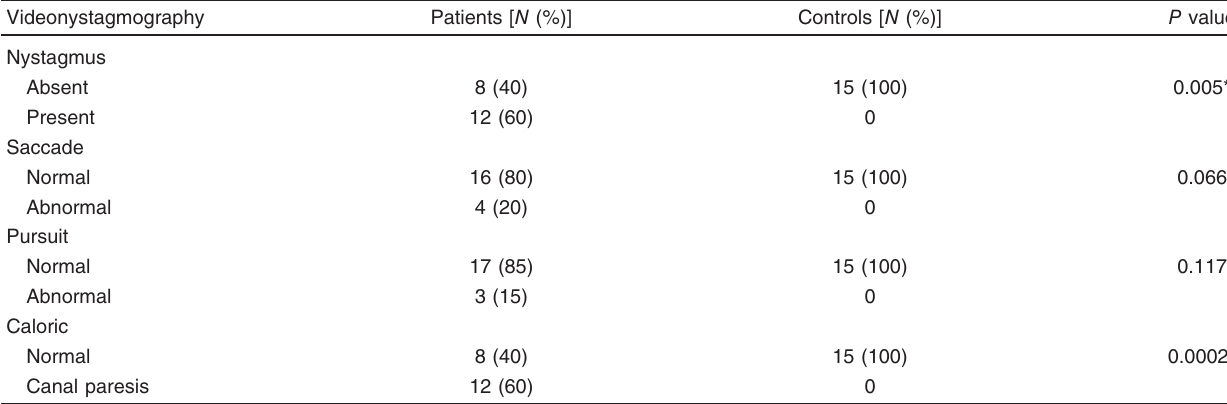
Table 4 Videonystagmography findings in patients with Parkinson disease and controls